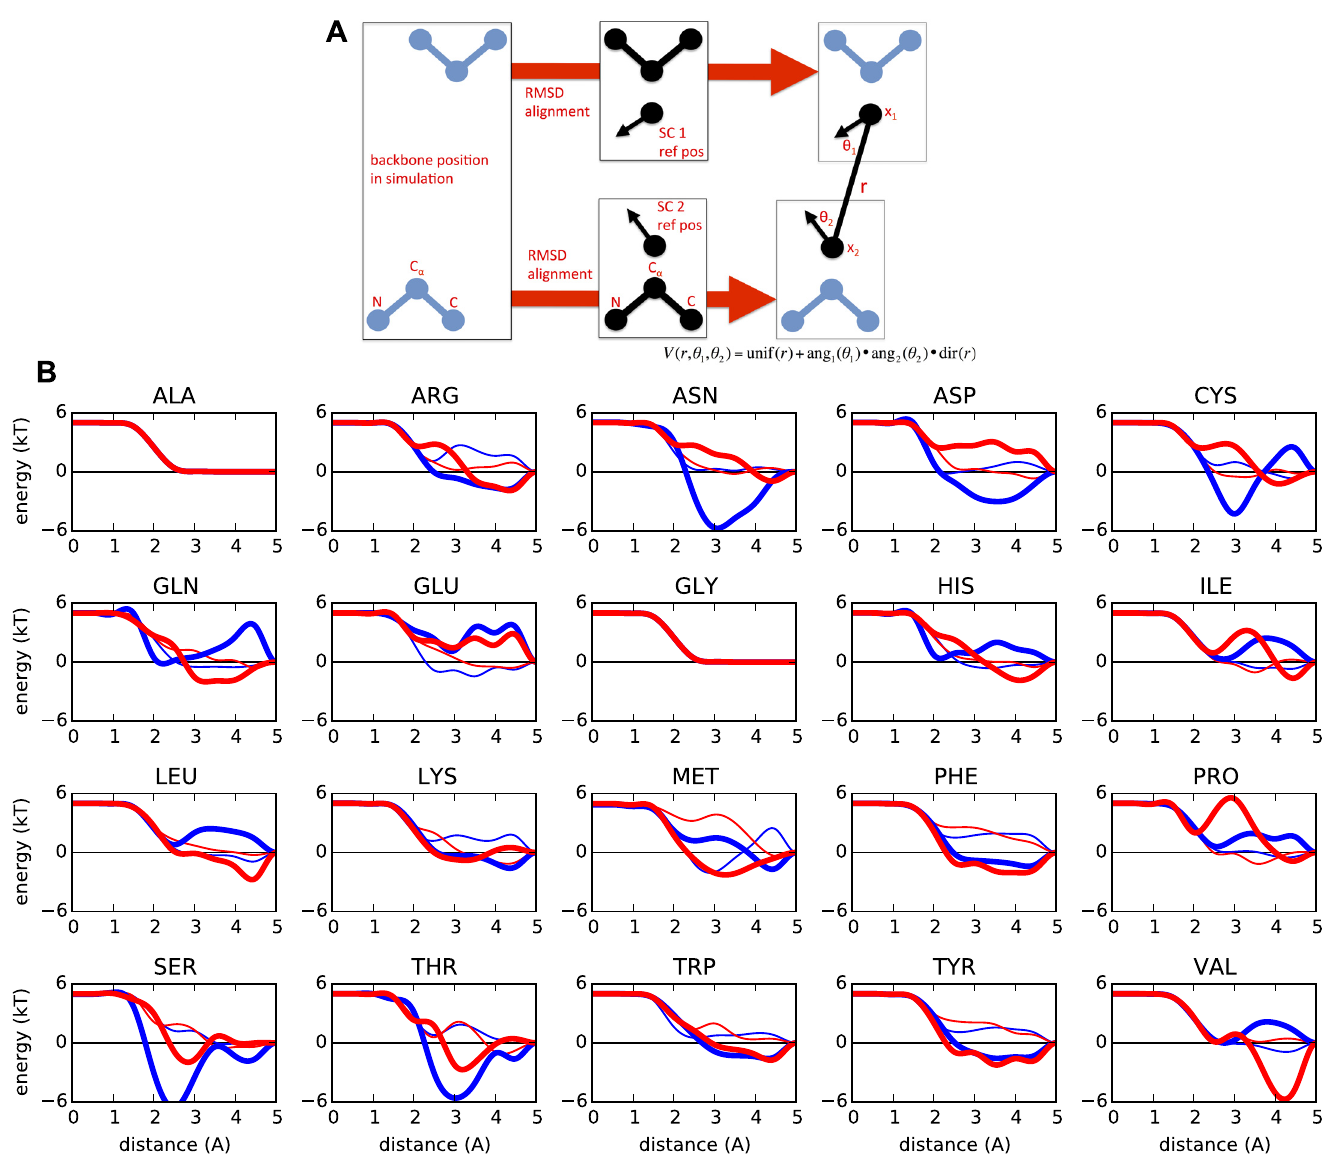
Fig 5. Coordinates and potentials used for side chain interactions. Top . For each residue, a reference backbone structure is aligned to the N, C α , and C atomic coordinates. This alignment creates a reference frame to establish the position and direction of the side chain bead. The two side chain beads x 1 and x 2 for a pair of residues establishes three coordinates, the distance r and angles θ 1 and θ 2 . Bottom . Example of distance-dependent potential, unif( r 12 ), after training, between the side chain and backbone residues. These interactions cutoff at 5 Å while the side chain-side chain interactions cutoff at 7 Å . The thin lines describe the V radial of oxygen (red) and hydrogen (blue), and the thick lines describe V radial + V angular for the same interactions.